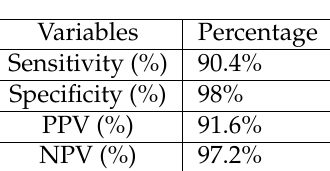
Figure 2. Graphic representation of the effect of ICT Solutions on total anthropogepainic GHG supply A sensitivity of 90.4%, specificity of 98%, PPV of 91.6% and NPV of 97.2% was seen (Table 3, Figure 3). Table 3. Accuracy of UACR